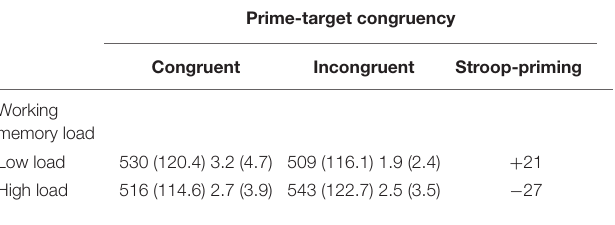
TABLE 2 | Mean (SD) correct reaction times (ms) and error percentages (in %) for congruent and incongruent trials in the Stroop task, under low and high WM load in Experiment